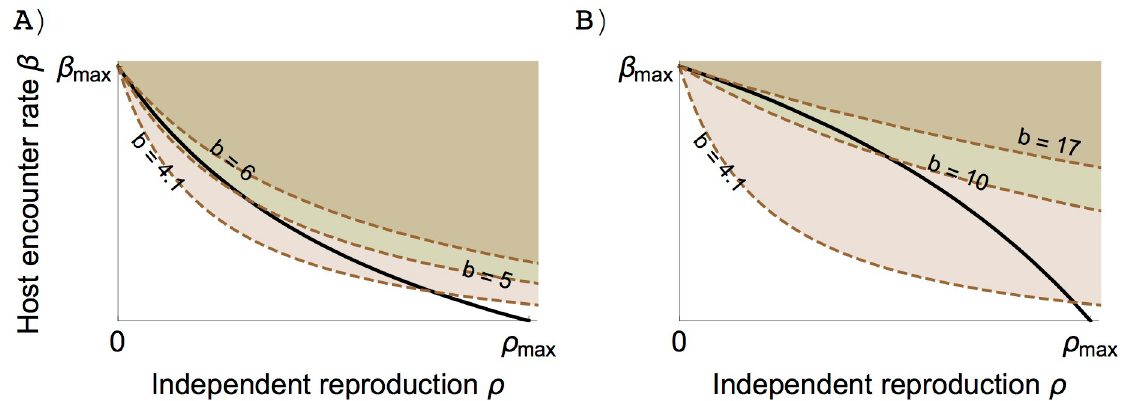
Fig 6. Different invasion boundaries (dashed lines) of the residents with zero independent reproduction and different values of the reproduction bonus b , assuming that τ ( x ) = ρ ( x ) + b . Trade-off and other conditions are similar to Fig 3. The higher the bonus reproduction, the less negative the slope of the invasion boundary compared with the slope of the trade-off curve (black line). A) Concave trade-off α = 3.1, δ = 1.3. B) convex trade-off α = 0.7, δ = 1.3. Other parameter values N = 10, c = 2, σ = 0, ν = 3, μ 0 = 3, β